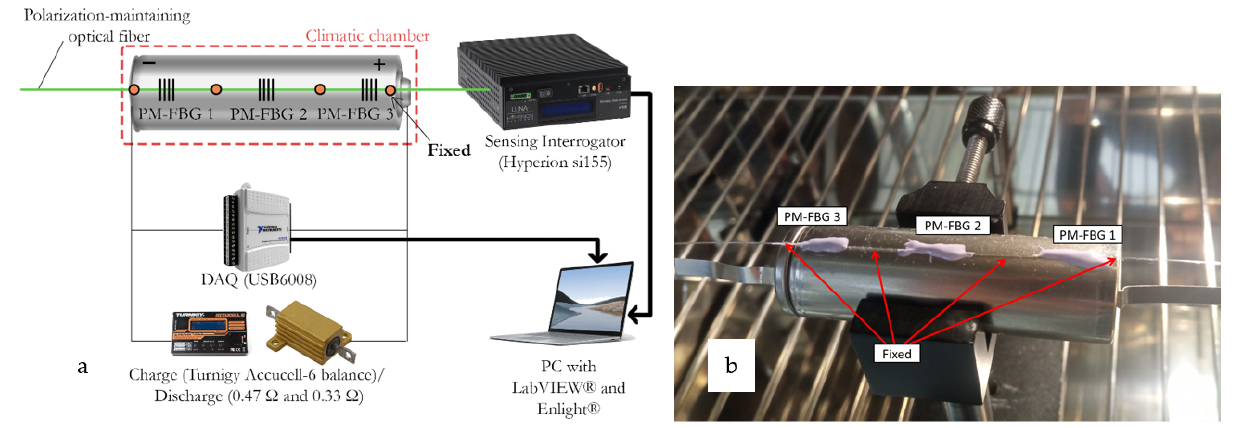
Figure 5. ( a ) Illustrative scheme of the experimental setup. ( b ) The optical fiber and the PM-FBG sensors fixed to the battery cell. The optical fiber was fixed to the battery after temperature calibration; thus, the experimental probe was in near-initial strain